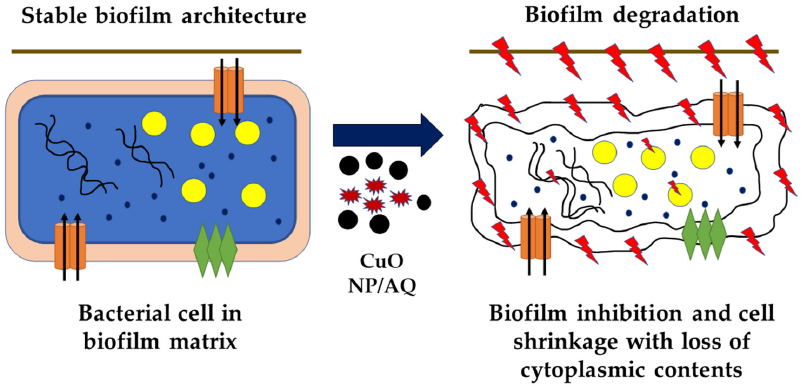
Figure 9. Schematic representation of CuO NPs/AQ combination action on the morphology of S. aureus cells.